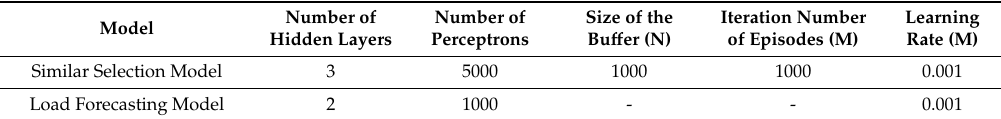
Table 2. Hyperparameters of the models for the case